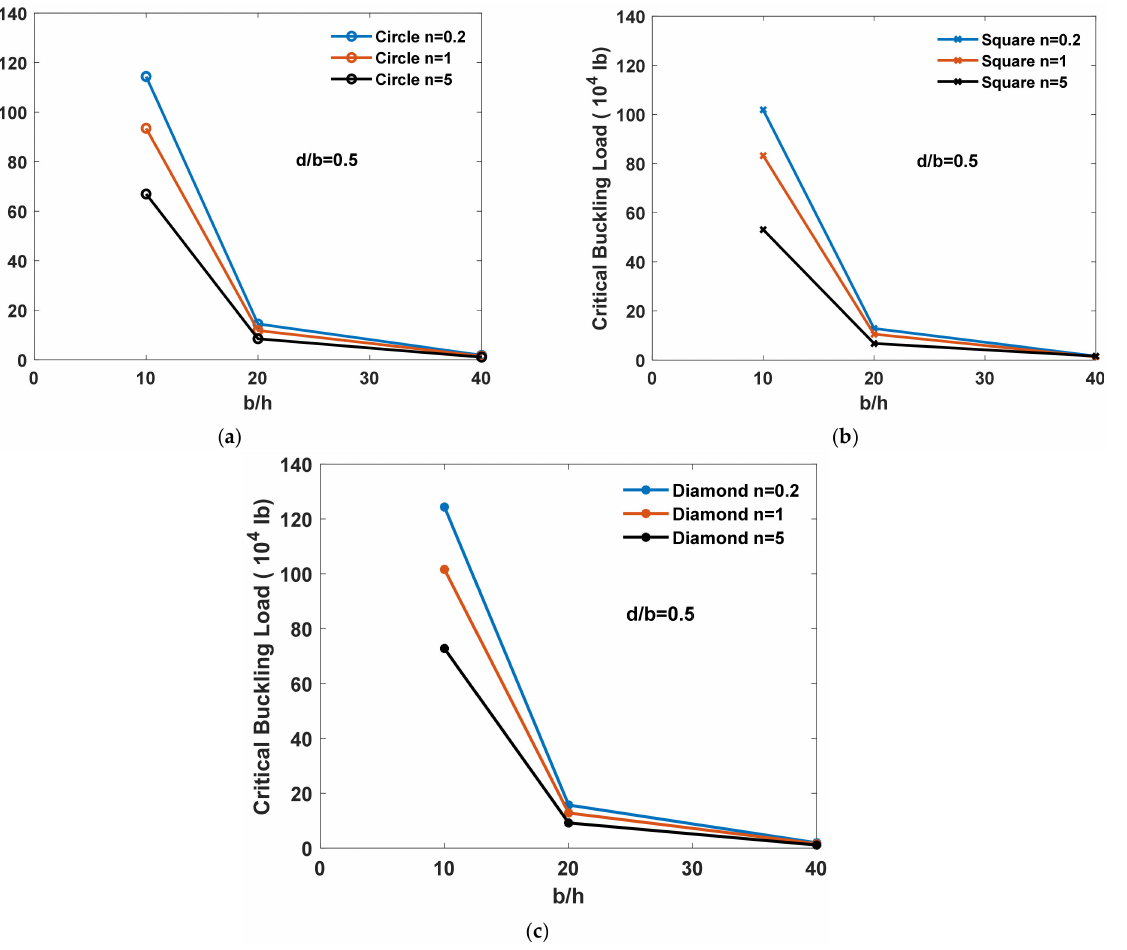
Figure 10. The variation of the aspect ratio on the critical buckling load for ( a ) circle, ( b ) square, and ( c ) diamond opening for an aspect ratio d/b =